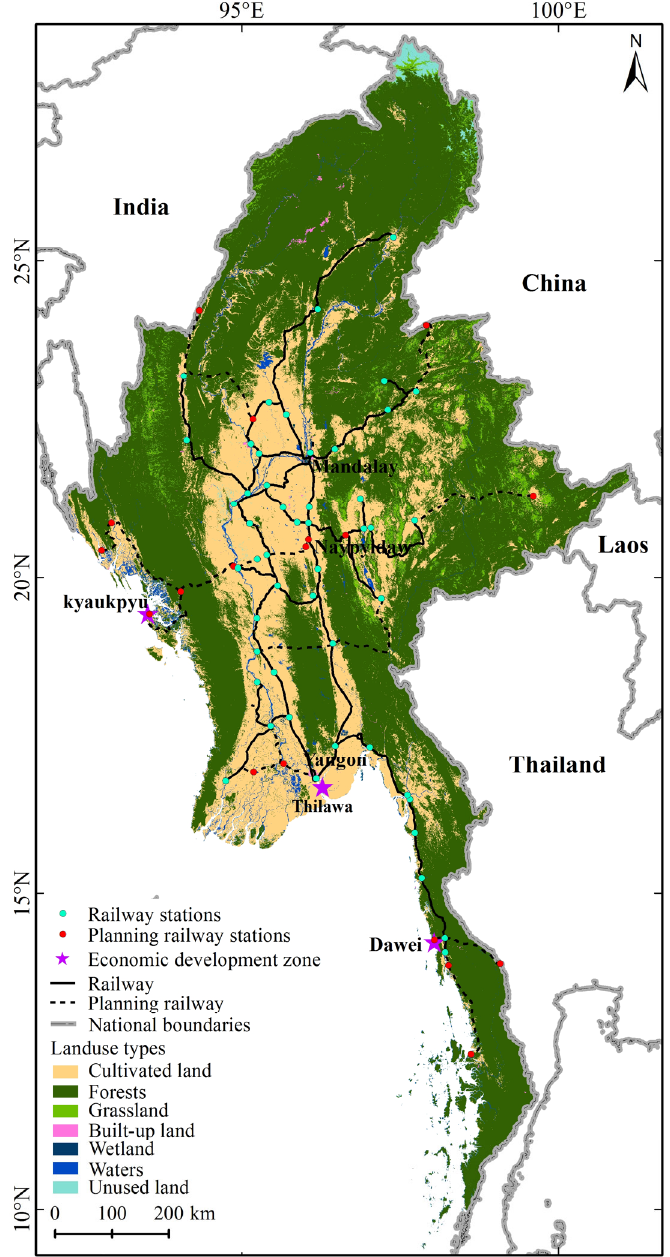
Figure 1. The study area showing land use distribution, existing railways and railway stations, planning railways, railway stations, and SEZs in Myanmar.